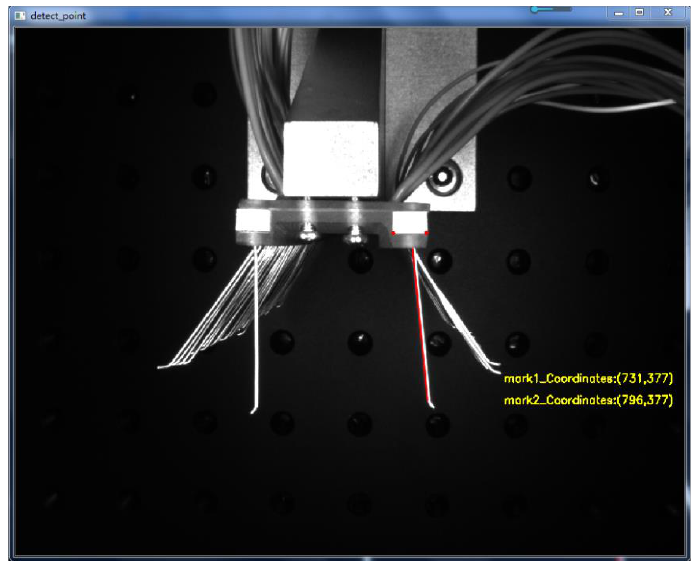
Figure 12. Brush wire corner point and edge straight line inspection diagram.